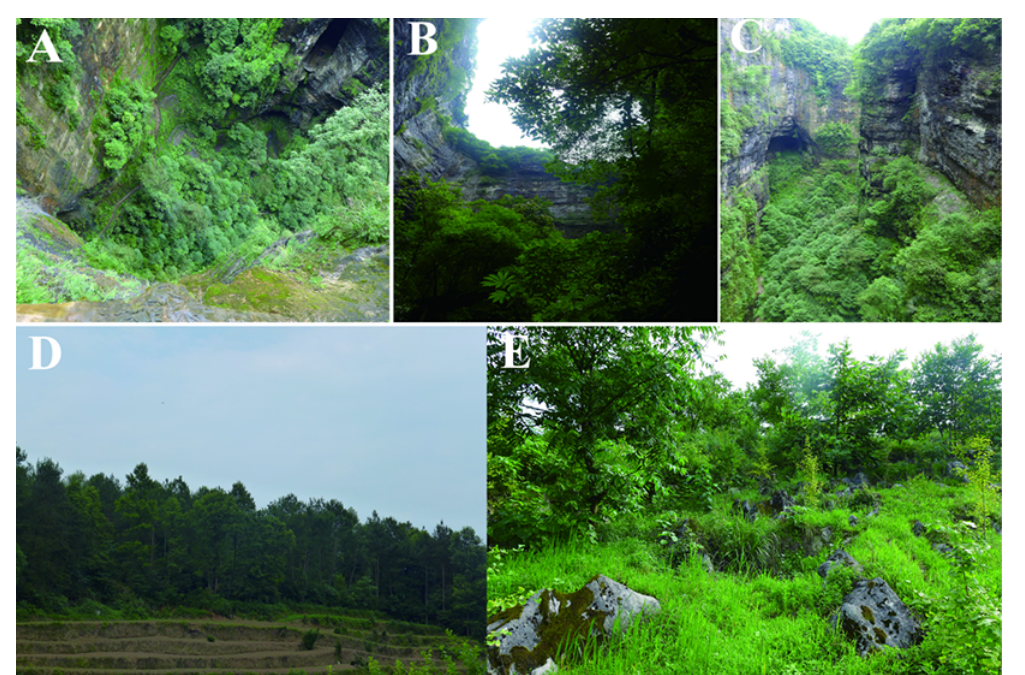
F igure 2 ( A ) Top view of the belowground level forest in the sinkhole (UFS). ( B ) View from the base to the top of the sinkhole (UFS). ( C ) Lateral view along the sinkhole (UFS). ( D ) View of the first forest on karst mountain plateau (FKM1). ( E ) View of the second forest onthe karst mountain plateau